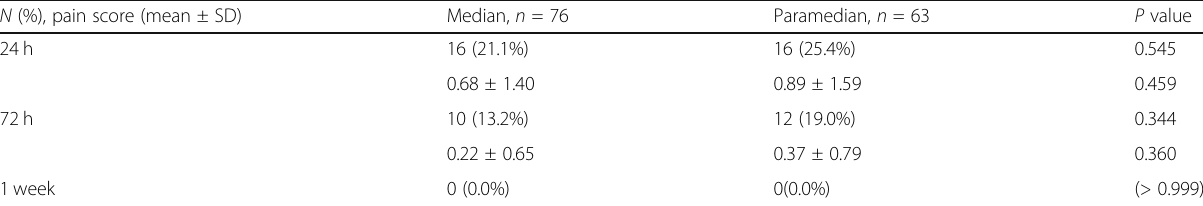
Table 3 Low back pain in two groups after spinal anesthesia N (%), pain score (mean ± SD)